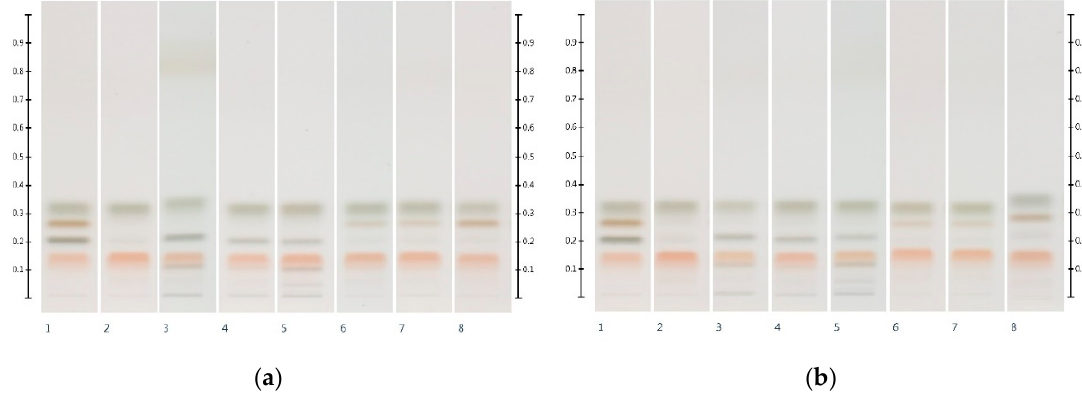
Figure 3. HPTLC images taken at T White light after derivatisation with aniline-diphenylamine- phosphoric acid reagent; ( a ) Track 1—Standards (fructose, maltose, sucrose and glucose in increasing Rf values), Track 2—MAN, Track 3—MAN-COR 30%, Track 4—MAN-RIC 30%, Track 5—MAN-GLU 30%, Track 6—MAN-GOL 30%, Track 7—MAN-TRE 30%, Track 8—MAN-MAP 30%; ( b ) Track 1— Standards (fructose, maltose, sucrose and glucose in increasing Rf values), Track 2—JAR, Track 3— JAR-COR 30%, Track 4—JAR-RIC 30%, Track 5—JAR-GLU 30%, Track 6—JAR-GOL 30%, Track 7— JAR-TRE 30%, Track 8—JAR-MAP 30%. Honey samples were analysed as a 3 µL aqueous methanolic honey solution.